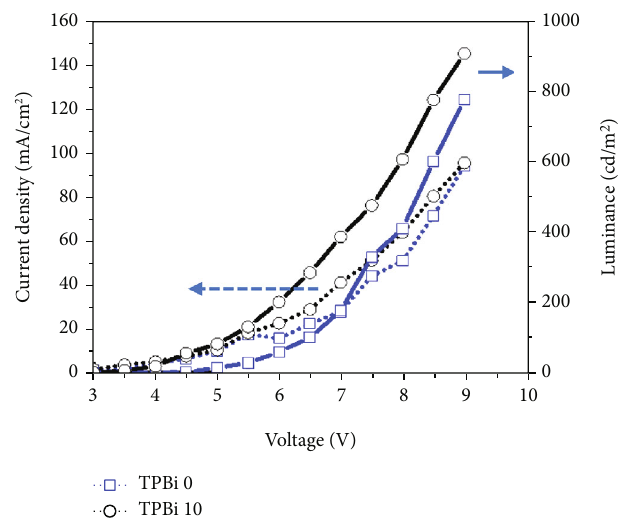
Figure 11: Current density-luminance-voltage characteristic curve characteristics of TE-OLED with electron transport/hole blocking layer TPBi.